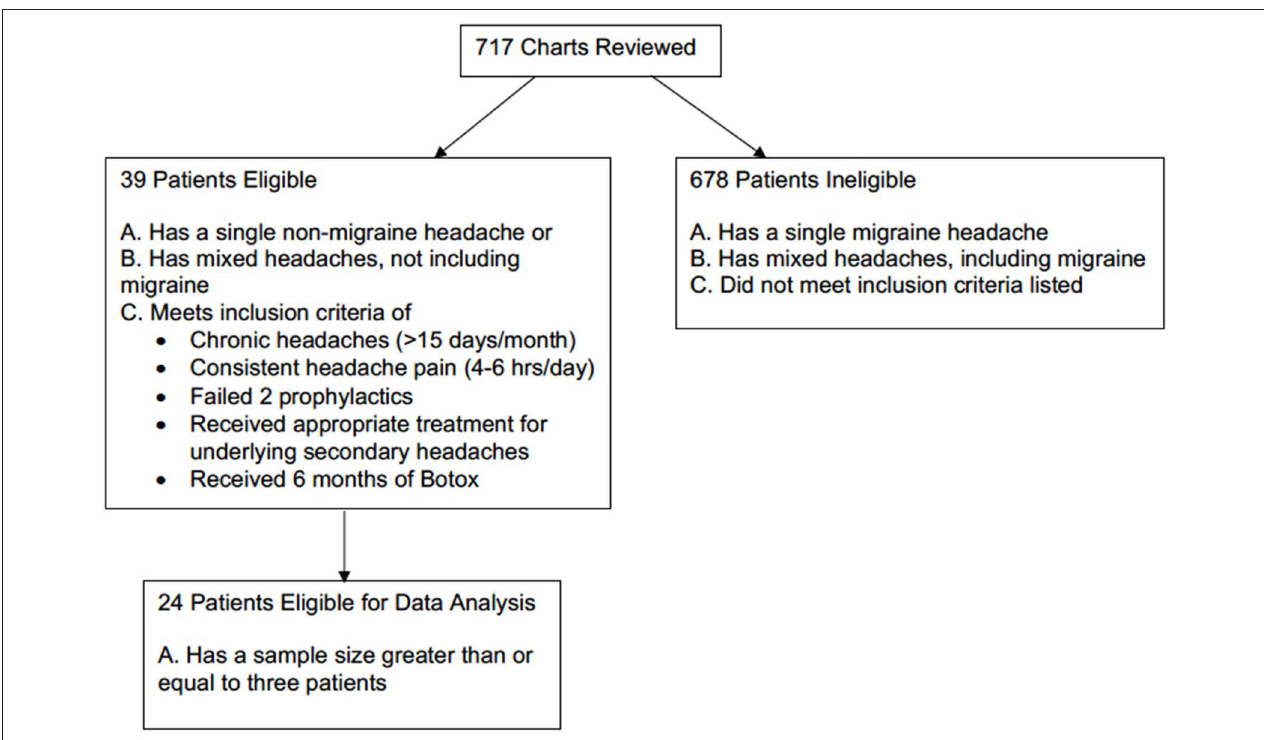
FIGURE 1 | Subject enrollment selection criteria.